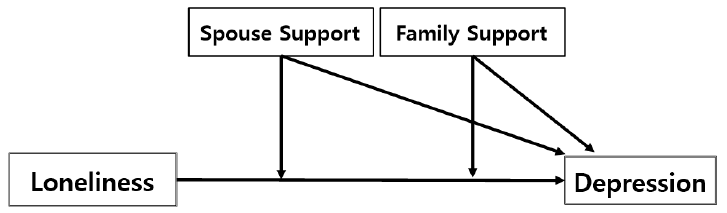
Figure 1. The Model of Moderation by Social